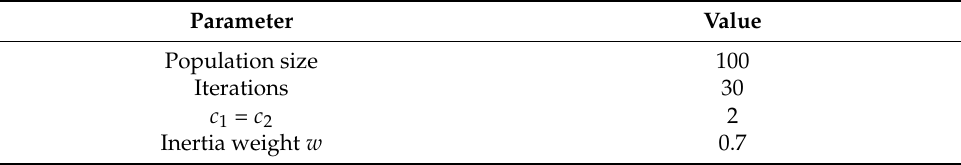
Table 5. PSO initial parameters.